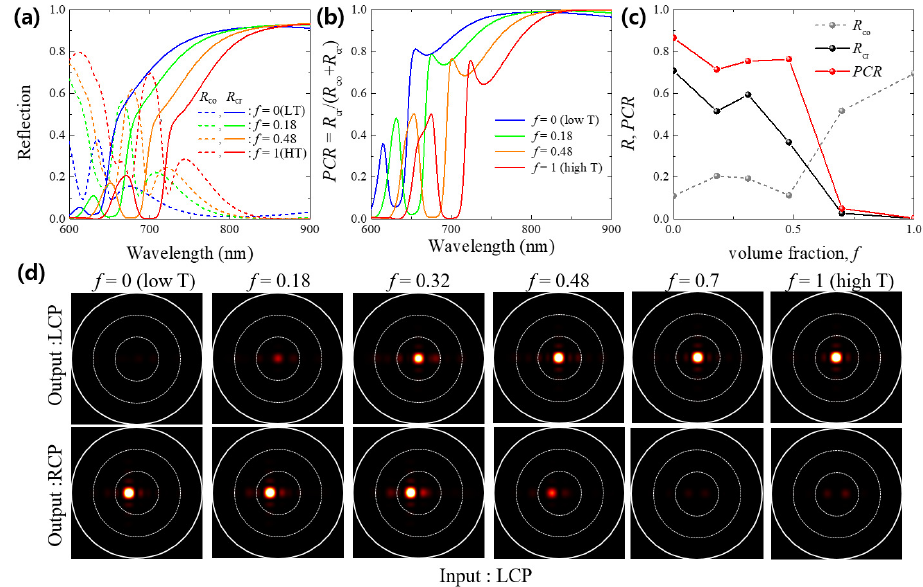
Figure 4. Characteristics of reflectivity in reflectarray metasurface with VO 2 thin film at different volume fraction of metal phase. ( a ) Reflection spectra of the co-polarized and cross-polarized light